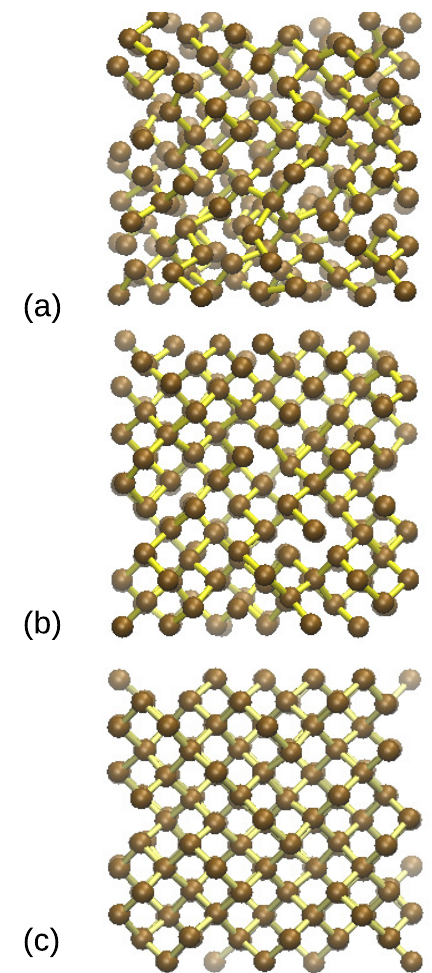
Figure 2. Calculated single-shot snapshots of atomic arrangements in silicon crystal at 500 fs after its irradiation with an X-ray pulse of 5.95 keV photon energy, duration of 25 fs FWHM, at the average absorbed doses in the material of ( a ) 2.70 eV/atom, ( b ) 1.35 eV/atom, and ( c ) 0.27 eV/atom. These correspond to 100%, 50%, and 10% of the nominal peak fluence,